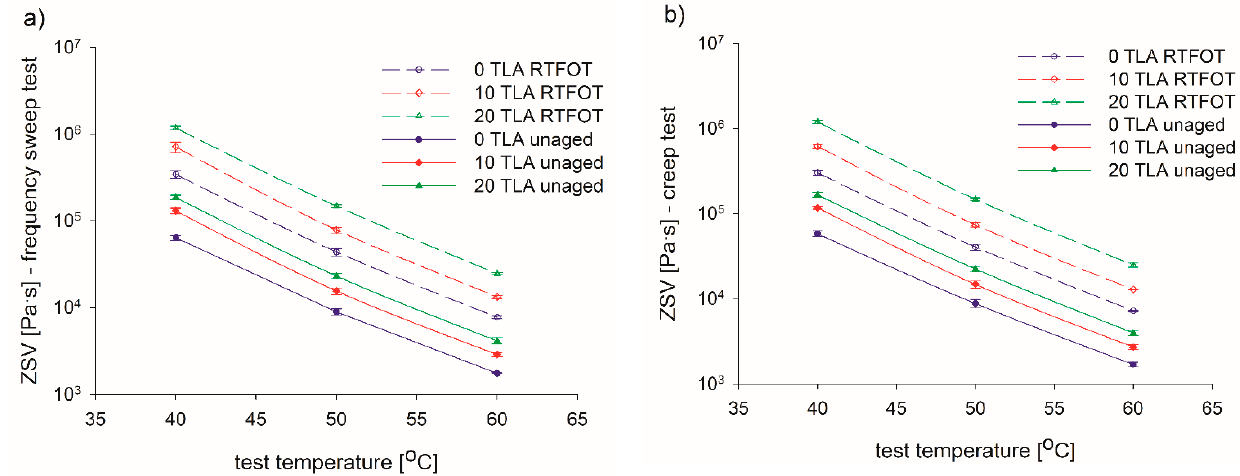
Figure 9. ZSV values of the tested binders from ( a ) frequency sweep test ( b ) and creep test models for various TLA contents and test temperatures before and after aging.